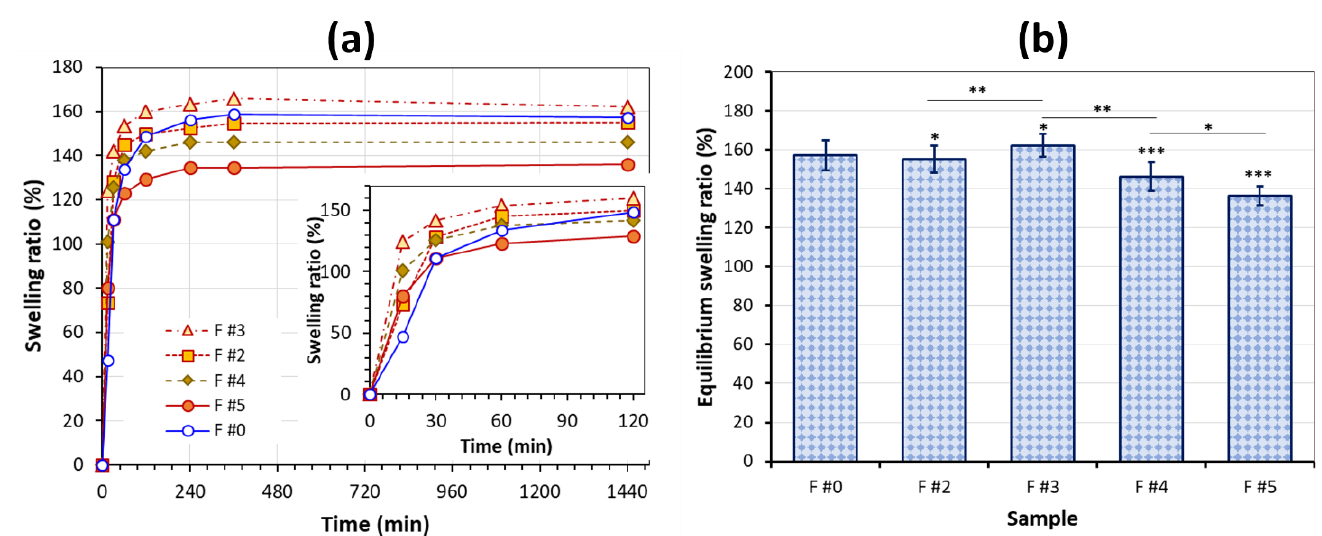
Figure 6. Swelling kinetics ( a ) and swelling degree at equilibrium (72 h) ( b ) of PVA/OxCS and composite PVA/OxCS-Ag films measured in phosphate buffer pH 6.8 and 37 °C. Results are expressed as mean ± standard deviation ( n = 3). * p < 0.05, ** p < 0.01, *** p < 0.001, compared with F #0.